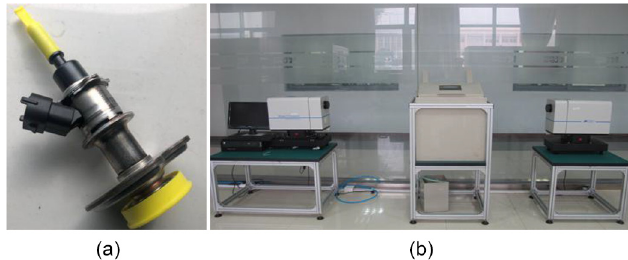
Fig. 5. Testing equipment for nozzle parameters. (a) nozzle. (b) Laser particle size analyzer.